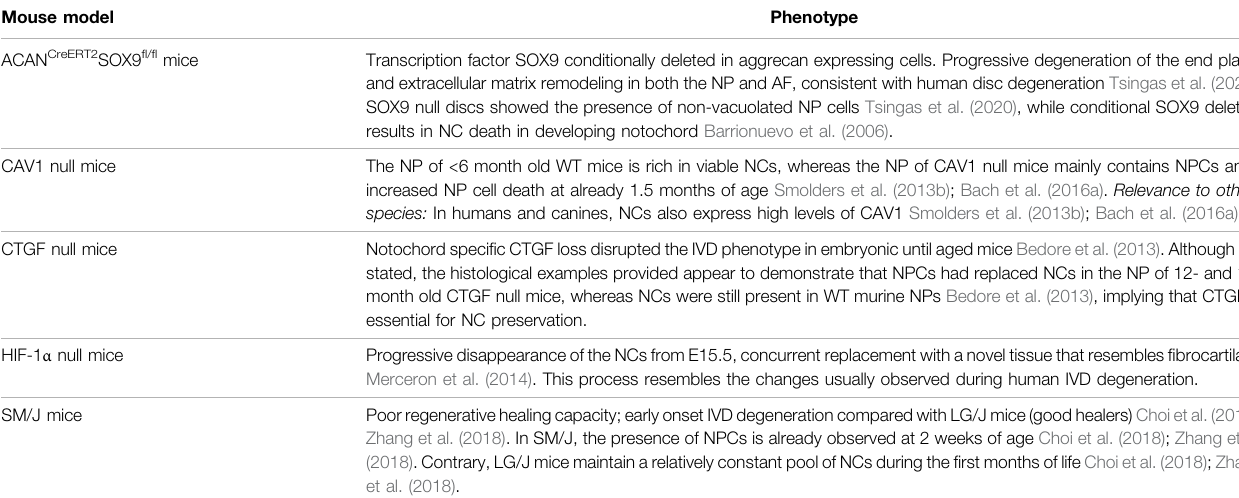
TABLE 2 | Mouse models and genes shown to play a role in preservation of the notochordal cell phenotype (in alphabetical order). Mouse